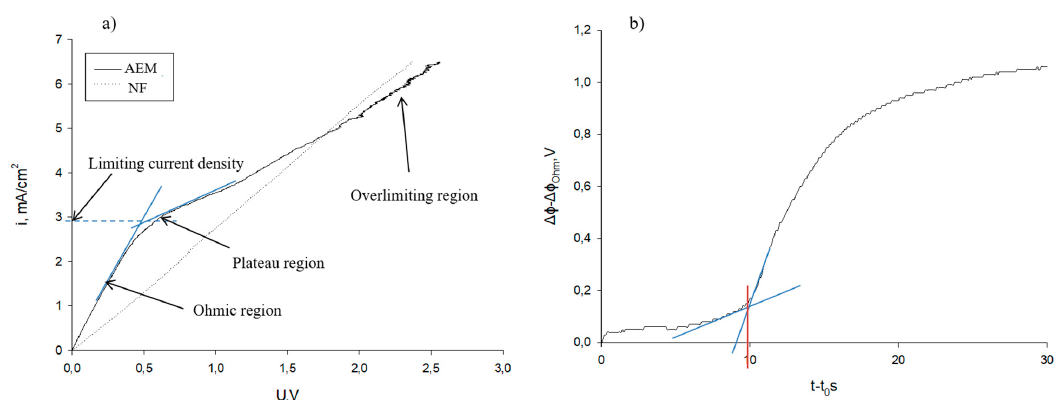
Figure 3. Representative ( a ) current–voltage (CV) curves for AEM and NF membranes and ( b ) ChP for an AEM membrane at current density of 2.9 mA/cm 2 .